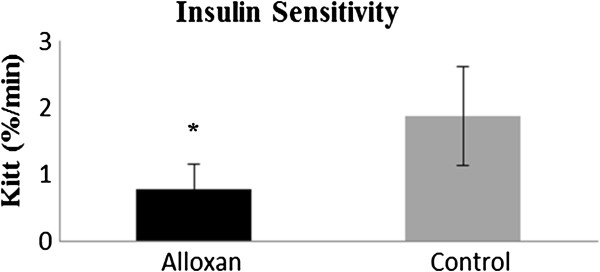
Serum glucose disappearance rate (Kitt, %/min) during the insulin tolerance test (ITT) at weaning (28 days). The results are expressed as the mean ± SD, n = 10 animals per group. The symbol * indicates significant difference (Student’s t test, p < 0.05) between groups (alloxan and control).